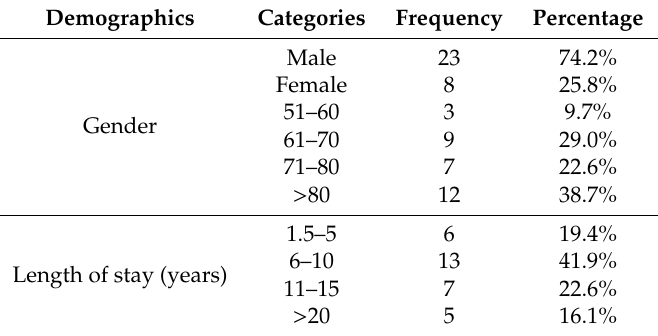
Table 3. Participants’